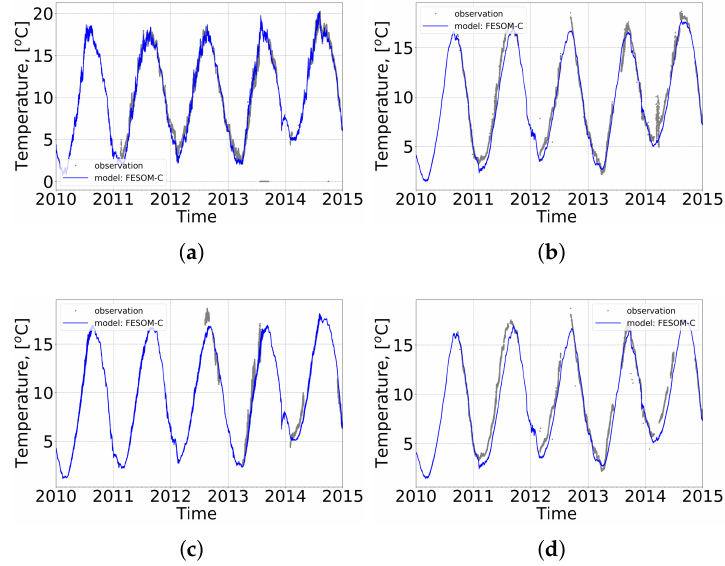
Figure 6. Comparison of observed (grey dots) and simulated (blue line) temperature at two stations: ( a , c ) the Helgoland station at 1 and 10 m depth, respectively; and ( b , d ) the UFS Deutsche Bucht station at 20 and 30 m depth,